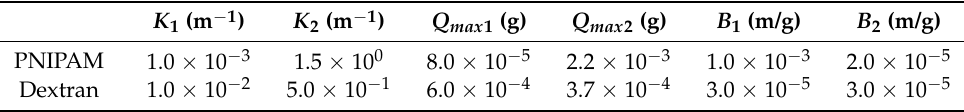
Table 2. Calculated fitting parameters to PE membrane.